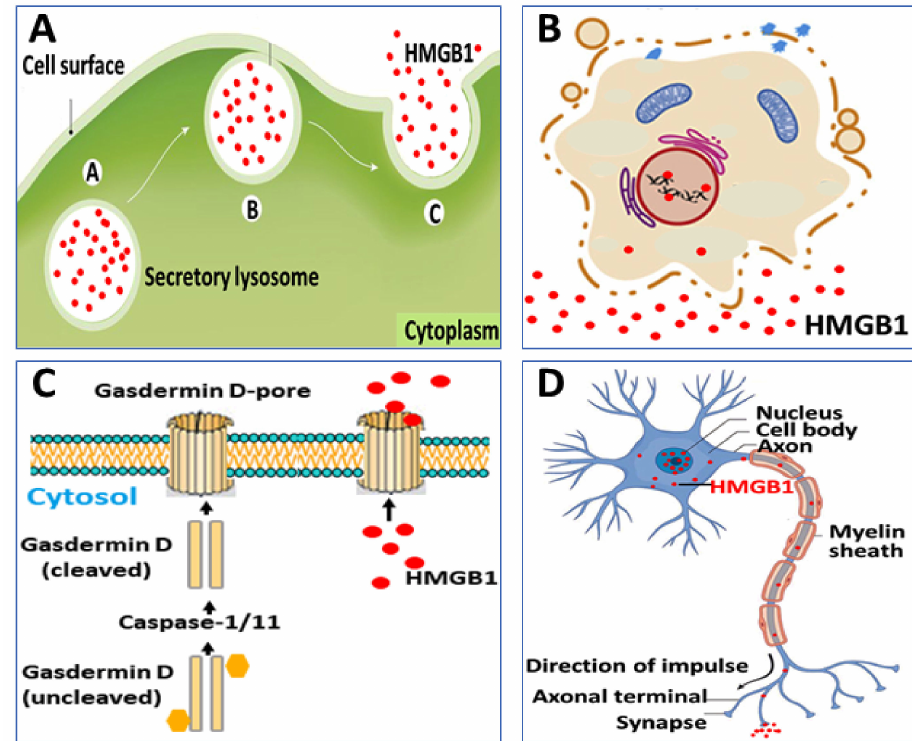
Figure 2. Selected examples of mechanisms for HMGB1 release. ( A ) HMGB1 lacks a secretory signal sequence and is instead packed into secretory lysosomes in hematopoietic cells, before being released extracellularly. ( B ) Pyroptosis and necrosis are both lytic processes that generate HMGB1 release, ( C ) Inflammasome-activated gasdermin D creates pore formation in the outer cell membrane enabling HMGB1 release even before cell lysis may occur. ( D ) Stimulated nociceptors release HMGB1 in a retrograde